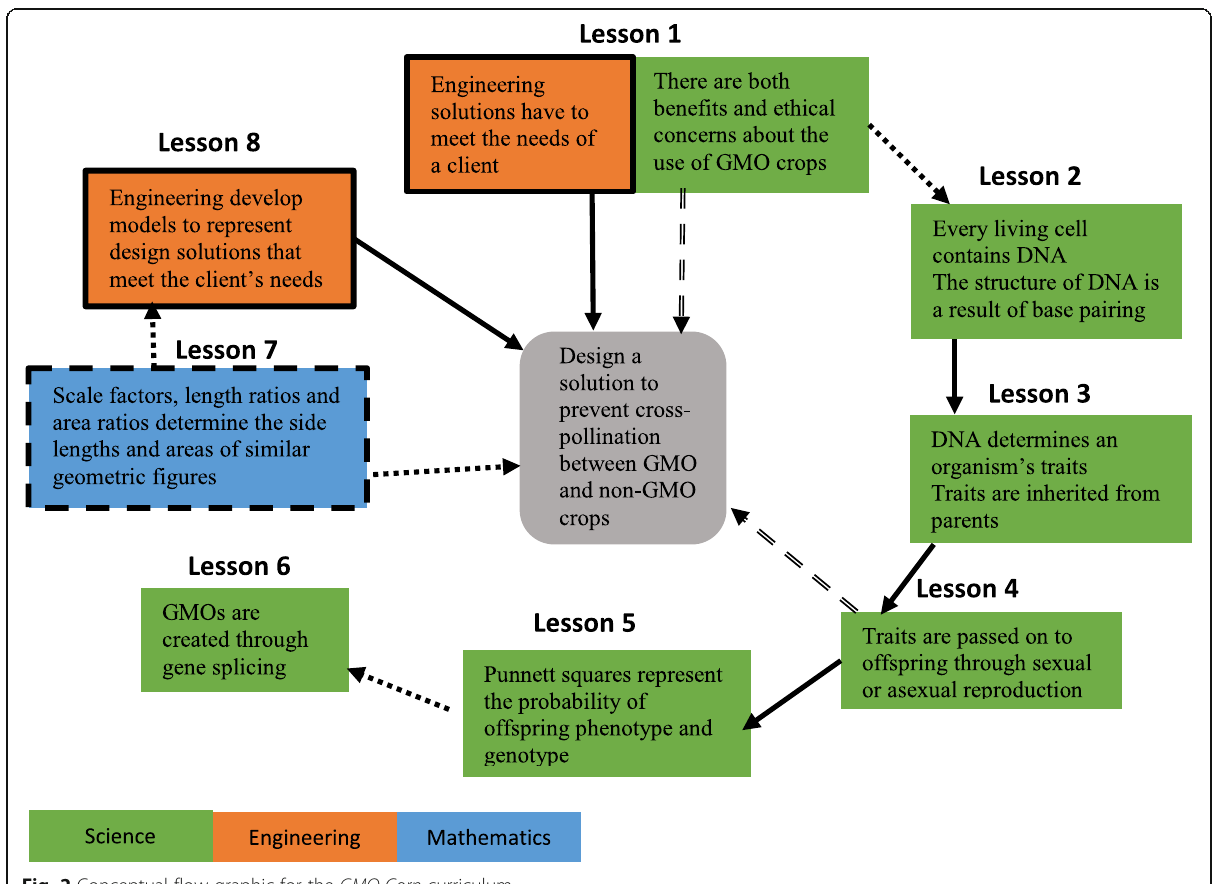
Fig. 2 Conceptual flow graphic for the GMO Corn